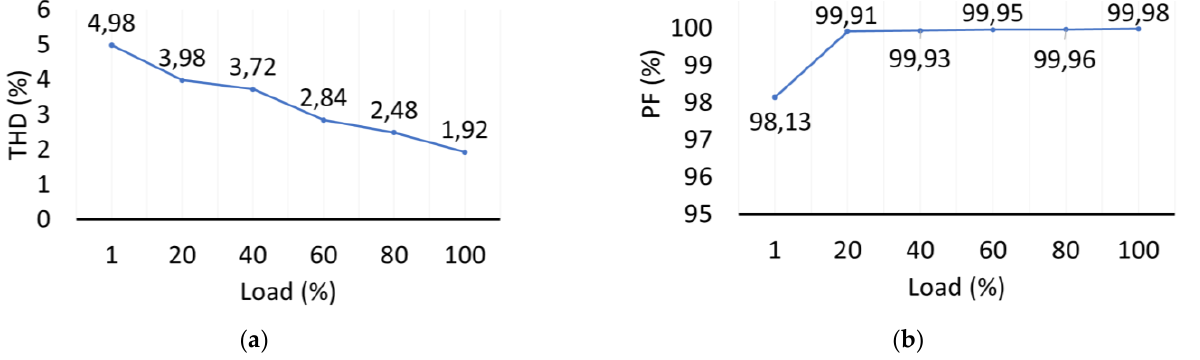
Figure 15. ( a ) THD for various load levels; ( b ) PF for various load levels.